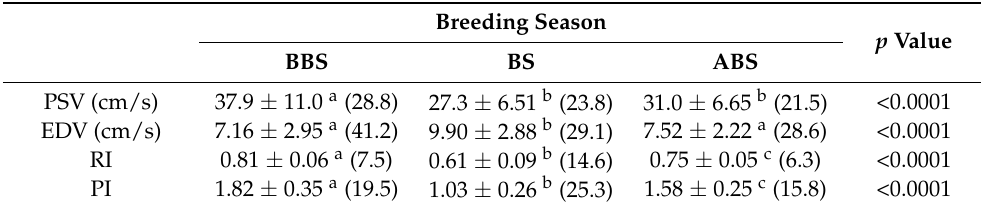
Table 4. The measures (mean ± SD (CV%)) of the blood flow measures in the testicular artery in the selected periods of routine ram examination in the herd, before the breeding season (BBS), during the breeding season (BS), and after the breeding season (ABS).